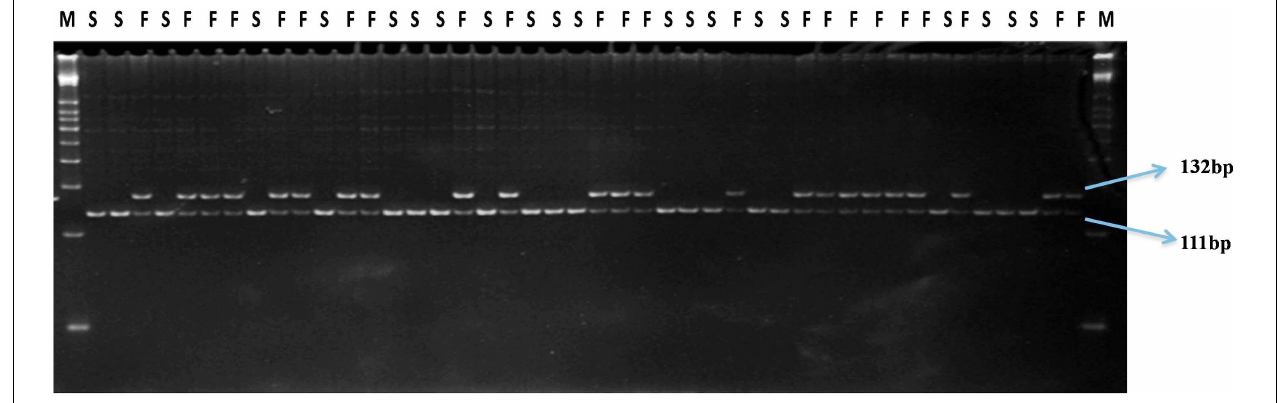
FIGURE 5 | Gel profile of SPGMS1-dCAPS marker linked to ms w gene in an F 6 NIL population; M, 50 bp DNA ladder; F, male fertile ( Ms w ms w ); S, male sterile ( ms w ms w ).